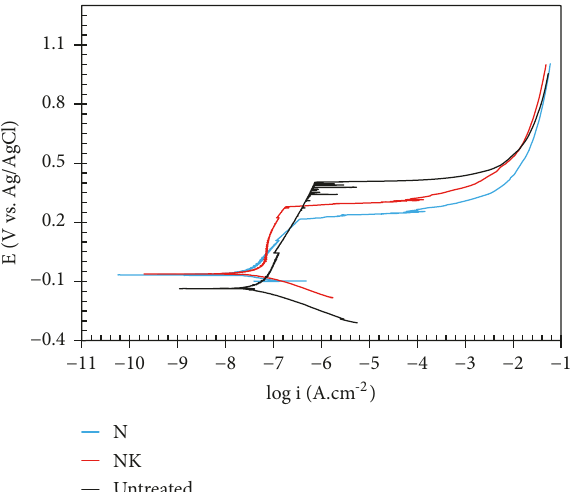
Figure 9: Potentiodynamic polarization curves for the untreated and nitrided samples. Electrolyte: 3.5 wt.% NaCl solution at room